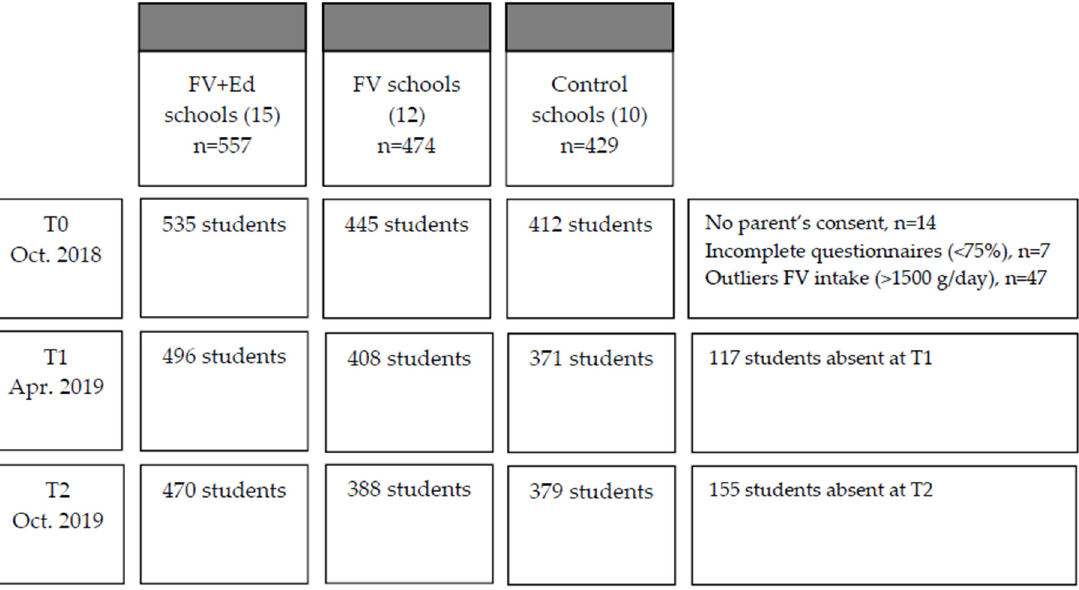
Figure 1. Study sample during the measurements and analyses ( n = number of students).